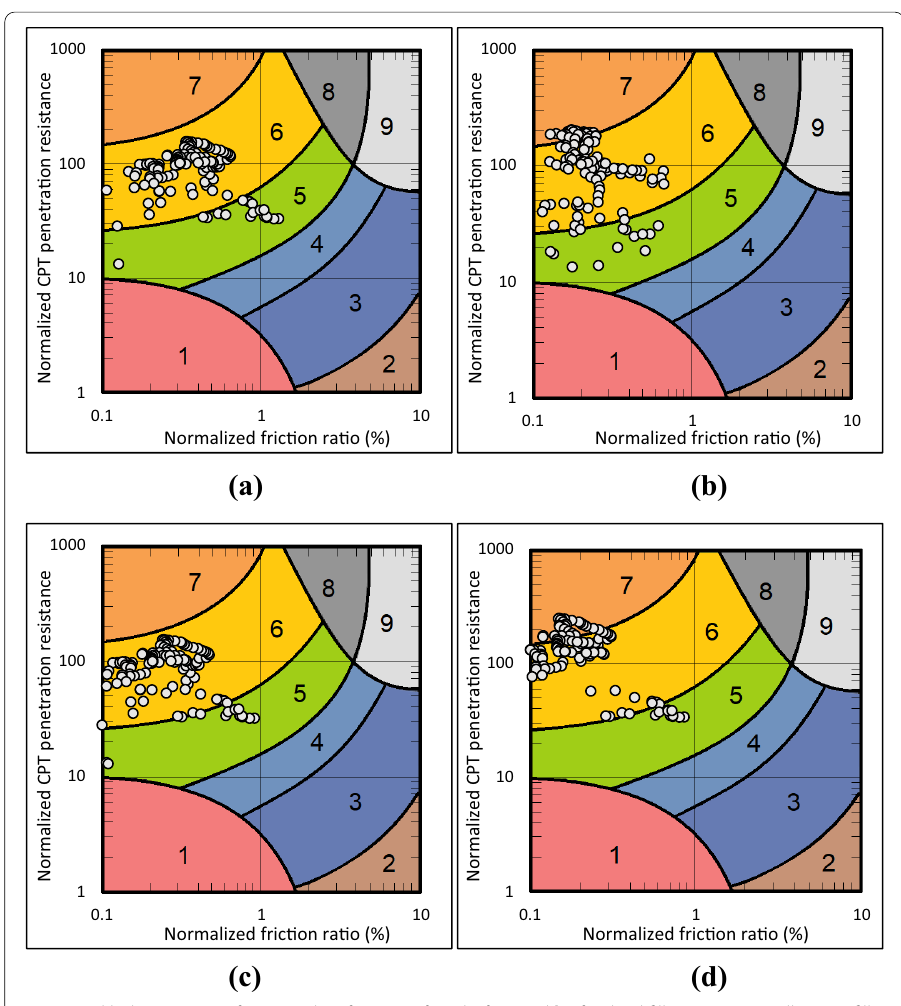
Fig. 6 Soil behavior type of CPT results of case N5 for a before and b after backfilling CPTs, as well as pre-fill CPT results converted to post-fill using c normalization method and d the approach introduced in this